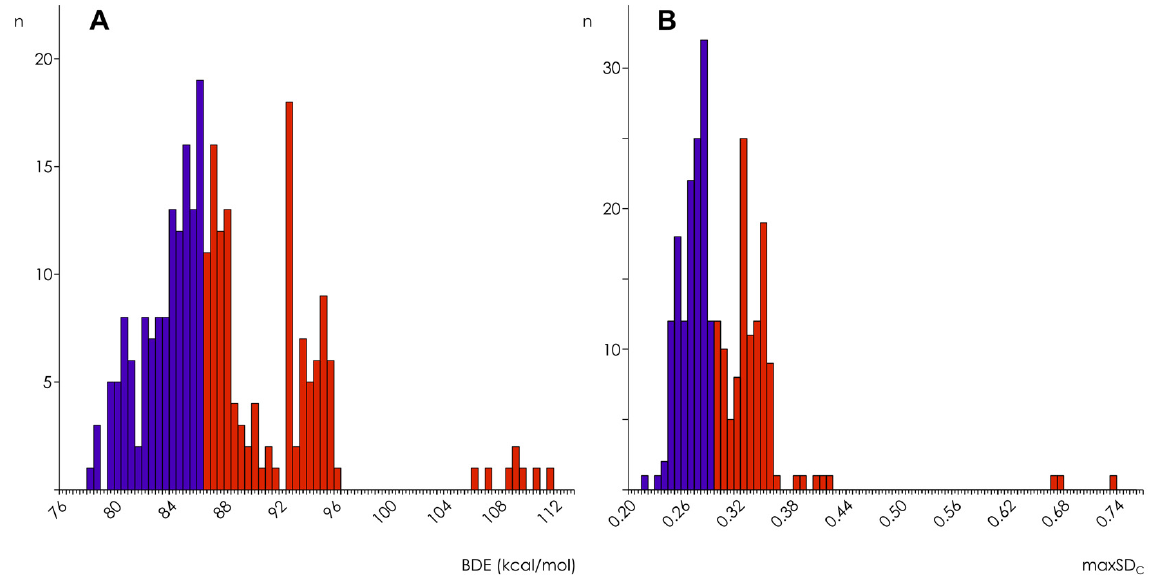
Figure 5. Distribution histograms of active and inactive hydroxyl groups by BDE ( A ) and maxSD C ( B ) threshold classifications in semi-empirical simulations using AM1 Hamiltonian without COSMO corrections ( n = 265). Red—inactive groups, purple—active groups.